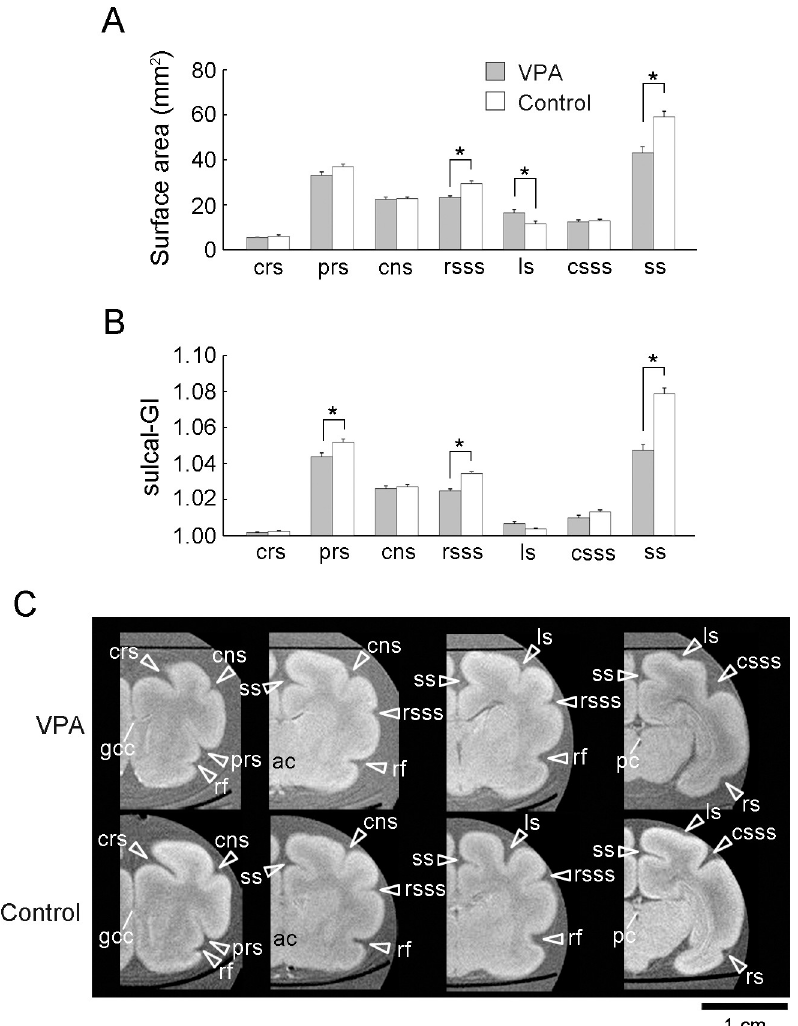
Fig 2. Sulcal surface areas, sulcal-GI, and ex vivo MRIs of the cerebrum in the coronal plane from VPA-treated and control ferrets at PD 20. (A) Bar graphs of the sulcal surface areas. (B) Sulcal gyrification index (sulcal-GI). (C) Ex vivo cerebrum MRIs in the coronal plane generated using RARE sequence with short TR and minimum TE settings. Coronal MRIs are shown from the left to right in the following order: the prefrontal region at the rostral end of the genu of the corpus callosum (gcc), the frontal region at the anterior commissure (ac), the parietotemporal region at the caudal end of the rhinal fissure, and the parieto-occipital region at the posterior commissure (pc). Data are shown as mean ± SEM. Significance is indicated using Scheffe’s test at � P < 0.001; number of cerebral hemispheres = 8. cns, coronal sulcus; crs, cruciate sulcus; csss, caudal suprasylvian; ls, lateral sulcus; prs, presylvian sulcus; rsss, rostral suprasylvian sulcus; ss, splenial